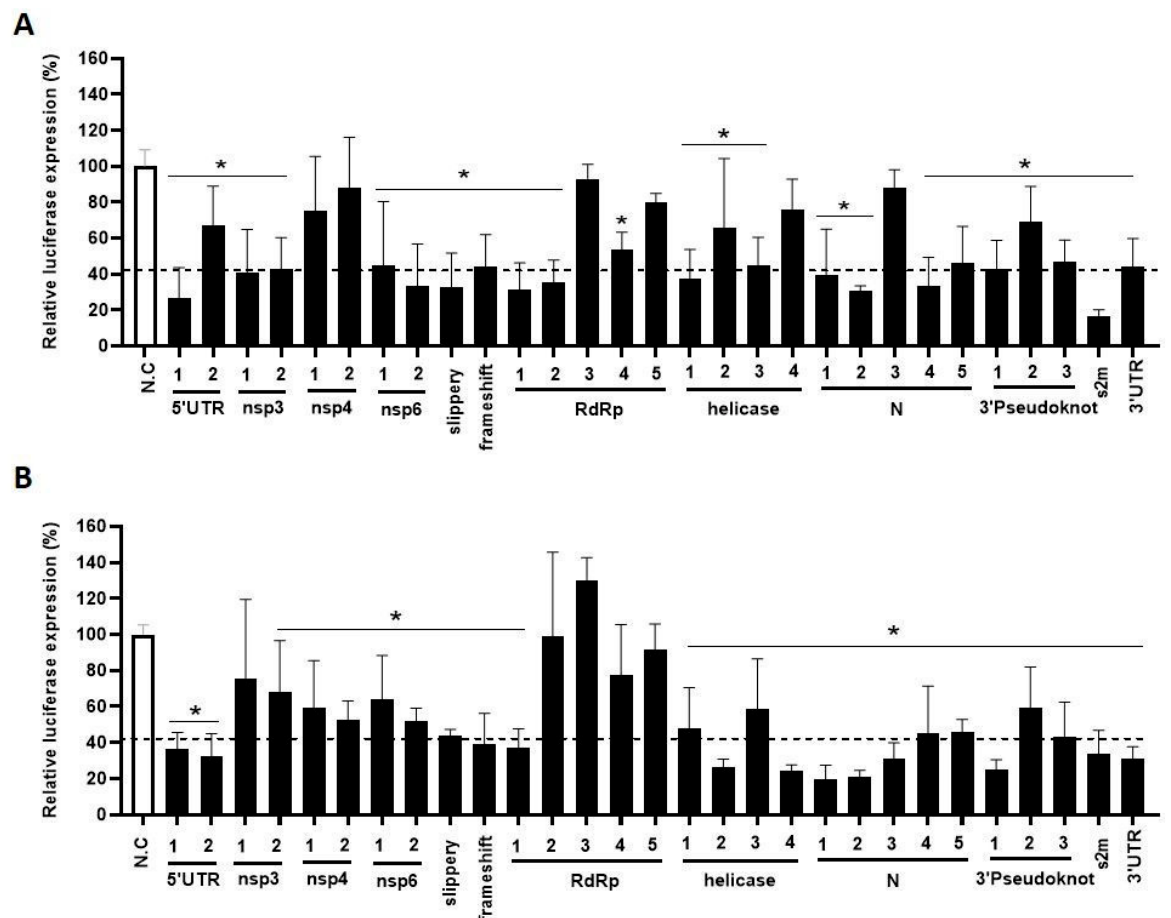
Figure 3. The efficiency of the designed anti-SARS-CoV-2 crRNAs. ( A , B ) The efficiency of 29 crRNAs targeting either the + or the -RNA strand with Cas13d was tested in HEK293T cells by co-transfecting them with the luciferase construct encoding SARS-CoV-2 +RNA ( A ) and − RNA ( B ) target sequences, respectively. To quantify viral gene expression, luciferase level was measured at two days after transfection. Mean values ( ± SD) of three experiments in duplicate are shown. The average luciferase levels are expressed as relative percentage level (%), setting the negative control (NC), a crRNA not targeting any SARS-CoV-2 encoding sequence, at 100%. Statistical significance was determined using one-way ANOVA, * p ≤ 0.05.